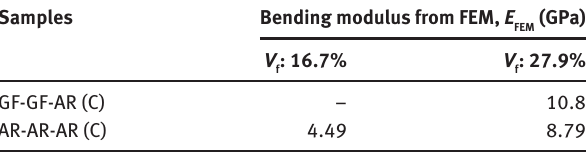
Table 10 Comparison of bending modulus of specimens from FEM with the same volume fractions.